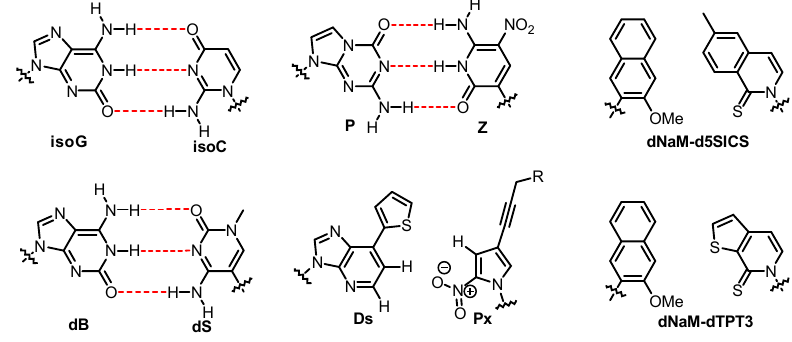
Figure 10. Structures of UBPs.